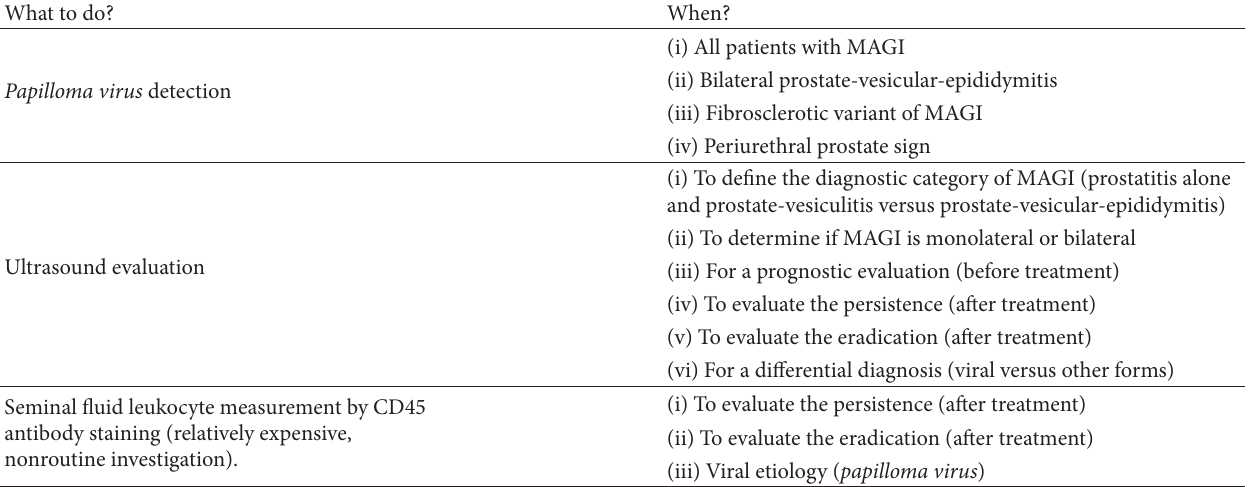
Table 4: Additional criteria for the clinical management of patients with male accessory gland infection/inflammation (MAGI). What to do? When? Papilloma virus